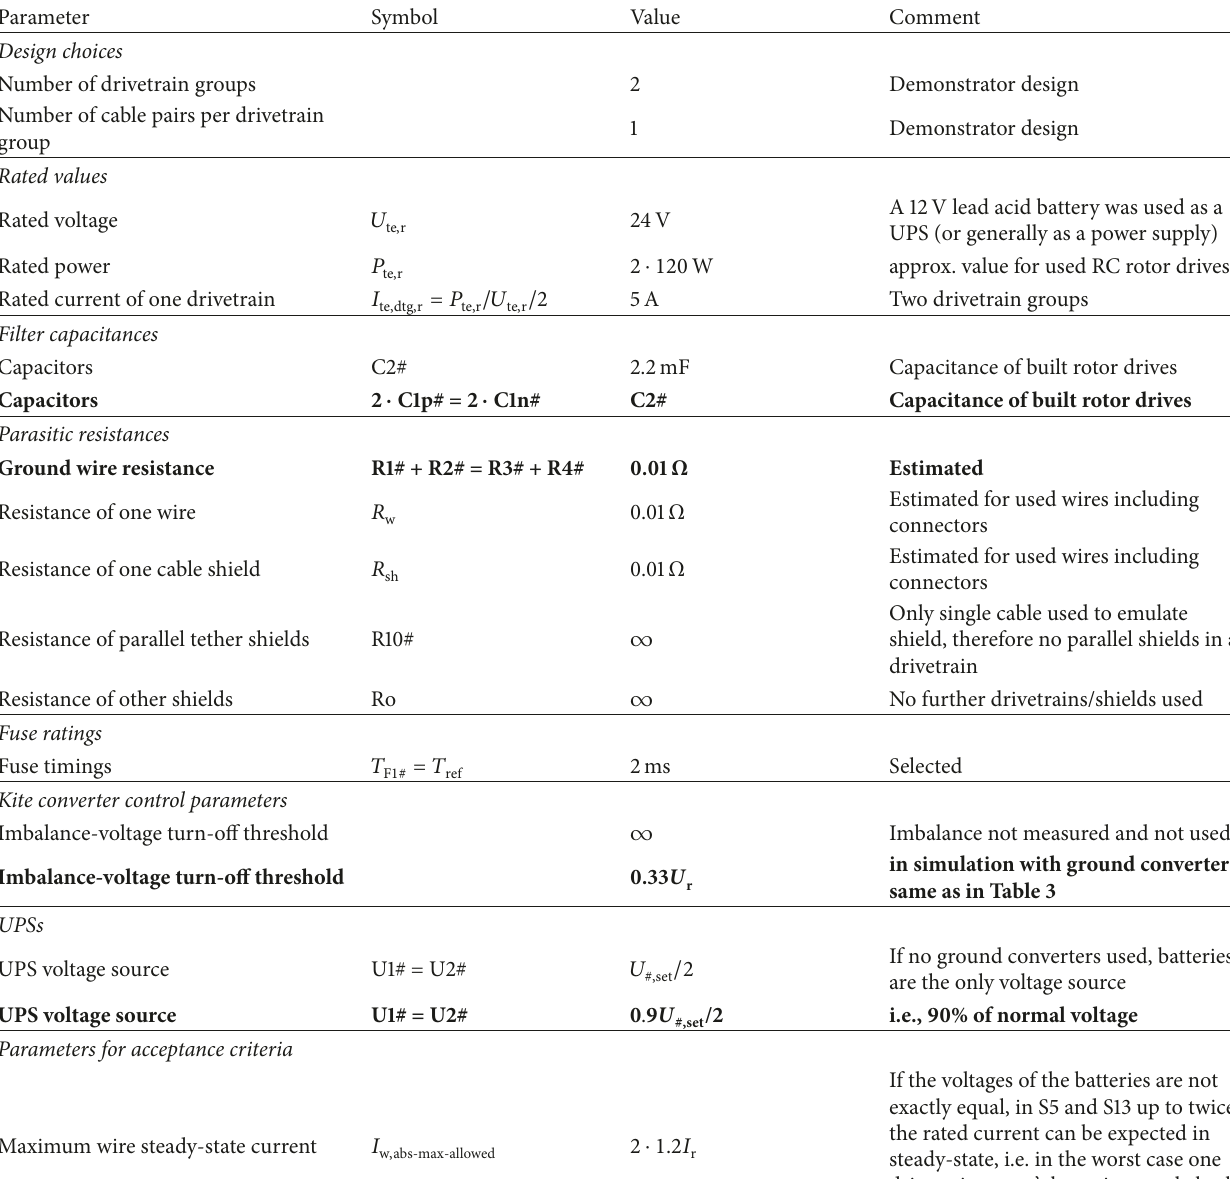
Table 5: Relevant parameters of the demonstrator other than in Table 3. The rows in bold are only relevant for a circuit simulation of the demonstrator with ground